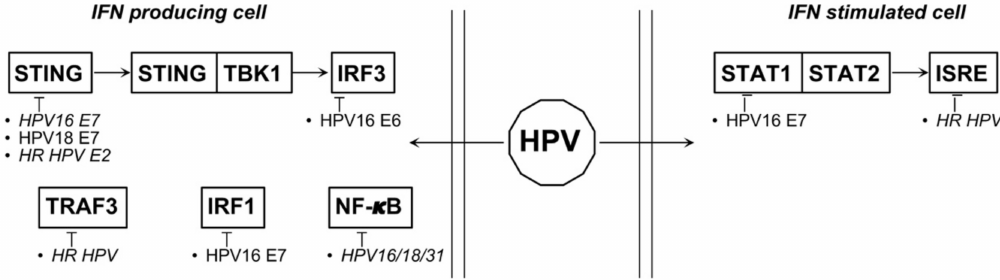
Figure 2. Proteins and miRNAs able to deregulate type I IFNs relevant pathways during HPV associated tumorigenesis. Italics represent indirect